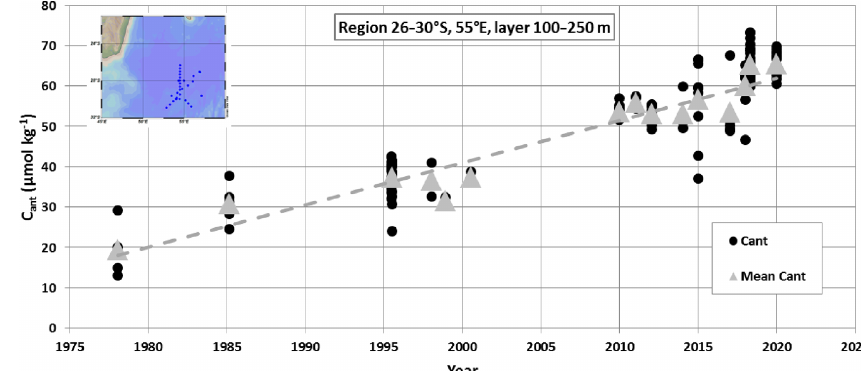
Figure 5. Time series of anthropogenic CO 2 concentrations ( C ant ) estimated in the subsurface (layer at 100–250m) in the region 26– 30 ◦ S, 55 ◦ E from the GLODAPv2.2021 data product (Lauvset et al., 2021a, b) completed with OISO cruises in 2012–2018 (loca- tion of selected stations in the insert map). The figure shows the C ant concentrations calculated for each sample (black dots) and the C ant averaged in the layer at 100–250m for each period (grey triangles). Over the period 1978–2020, the C ant long-term trend is + 1.05 ( ± 0 . 08)µmolkg − 1 yr − 1 (dashed grey line).